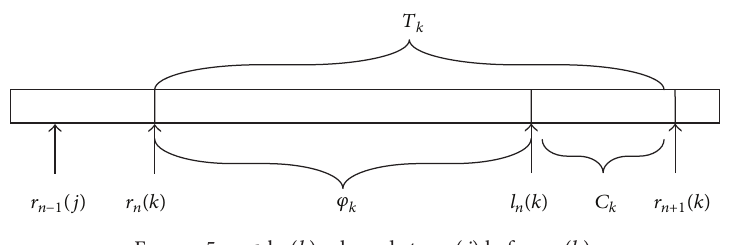
Figure 5: 𝜏 𝑗 ∈ hp (𝑘) released at 𝑟 𝑛−1 (𝑗) before 𝑟 𝑛 (𝑘) .